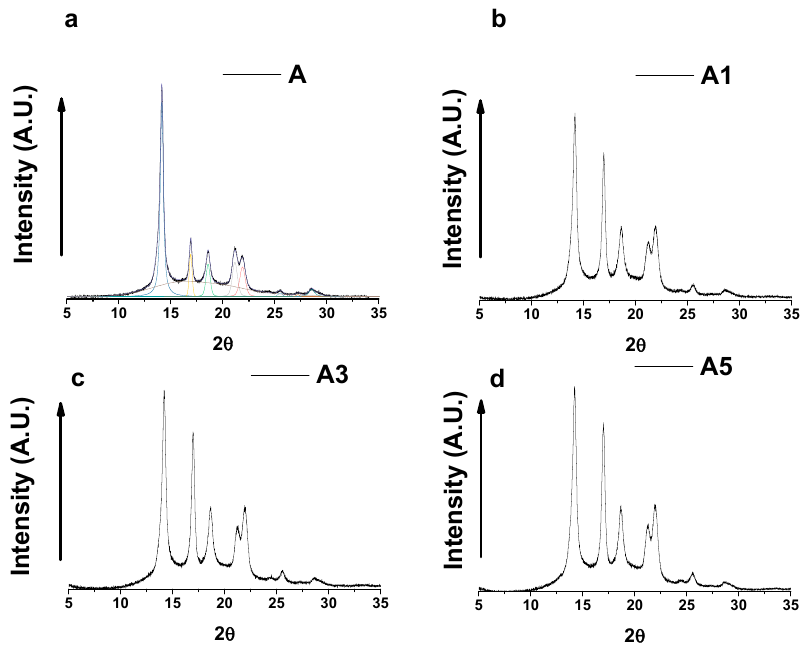
Figure 11. X-ray diffractograms of samples A, A1, A3 and A5.